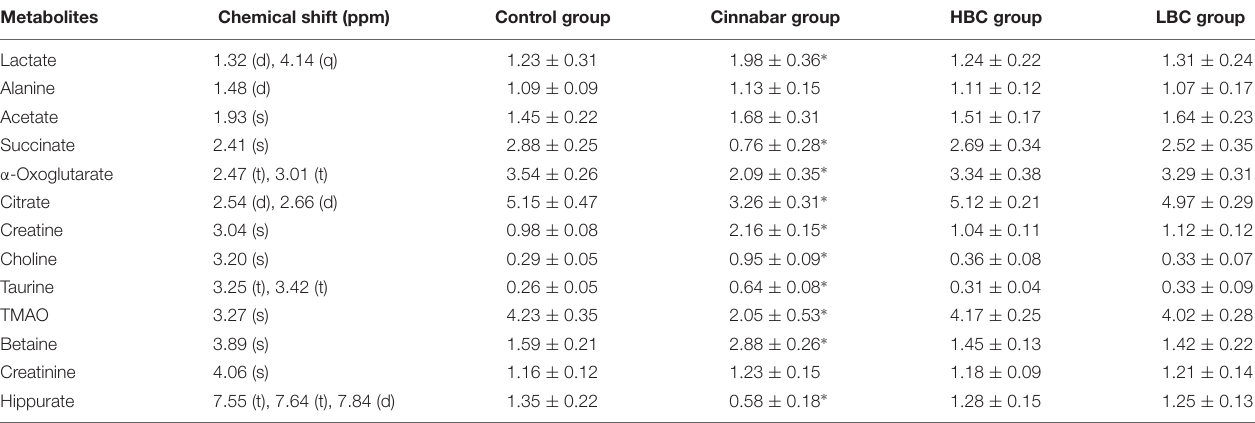
FIGURE 4 | Partial least squares-discriminant analysis scores plot (A) based on 1 H NMR spectra of urine from the four groups. PLS-DA scores plot (B,C) from the three groups. PLS-DA scores plot (D) based on 1 H NMR spectra of serum from the four groups. PLS-DA scores plot (E,F) from the three groups. PLS-DA scores plot (G) and corresponding loadings plot (H) based on 1 H NMR spectra of urine from control group and LBC group. PLS-DA scores plot (I) and corresponding loadings plot (J) based on 1 H NMR spectra of urine from control group and HBC group. PLS-DA scores plot (K) and corresponding loadings plot (L) based on 1 H NMR spectra of serum from control group and LBC group. PLS-DA scores plot (M) and corresponding loadings plot (N) based on 1 H NMR spectra of serum from control group and HBC group. Key: cinnabar group (Blue), control group (Green), LBC group (Red), HBC group (Yellow). TABLE 2 | 1 H NMR-relative integral levels of metabolites in urine samples of groups control, cinnabar, HBC,